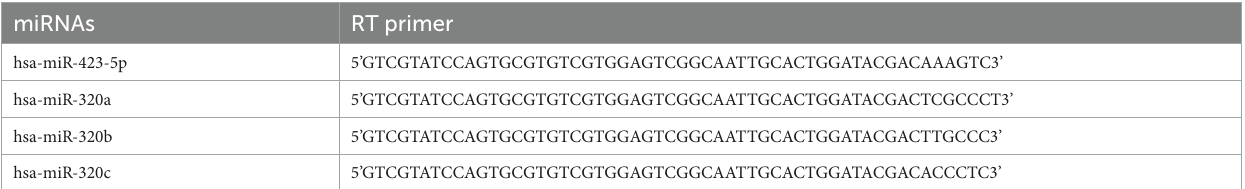
TABLE 1 RT primers for cDNA synthesis.